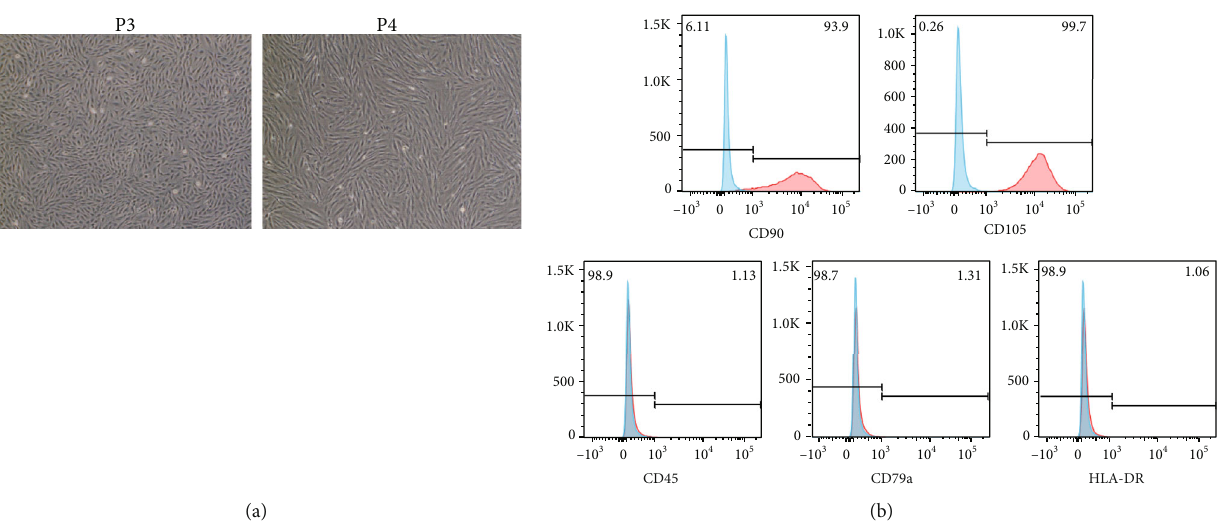
Figure 2: Characterization of ERCs. (a) Cell morphology of ERCs at P3 and P4. (b) Flow cytometry analysis of ERCs. Surface markers CD90, CD105, CD45, CD79a, and HLA-DR were